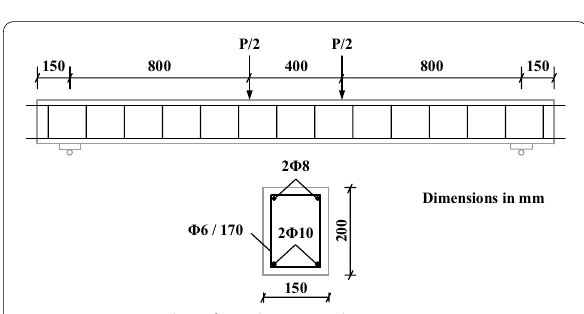
Fig. 4 Deteriorated reinforced concrete